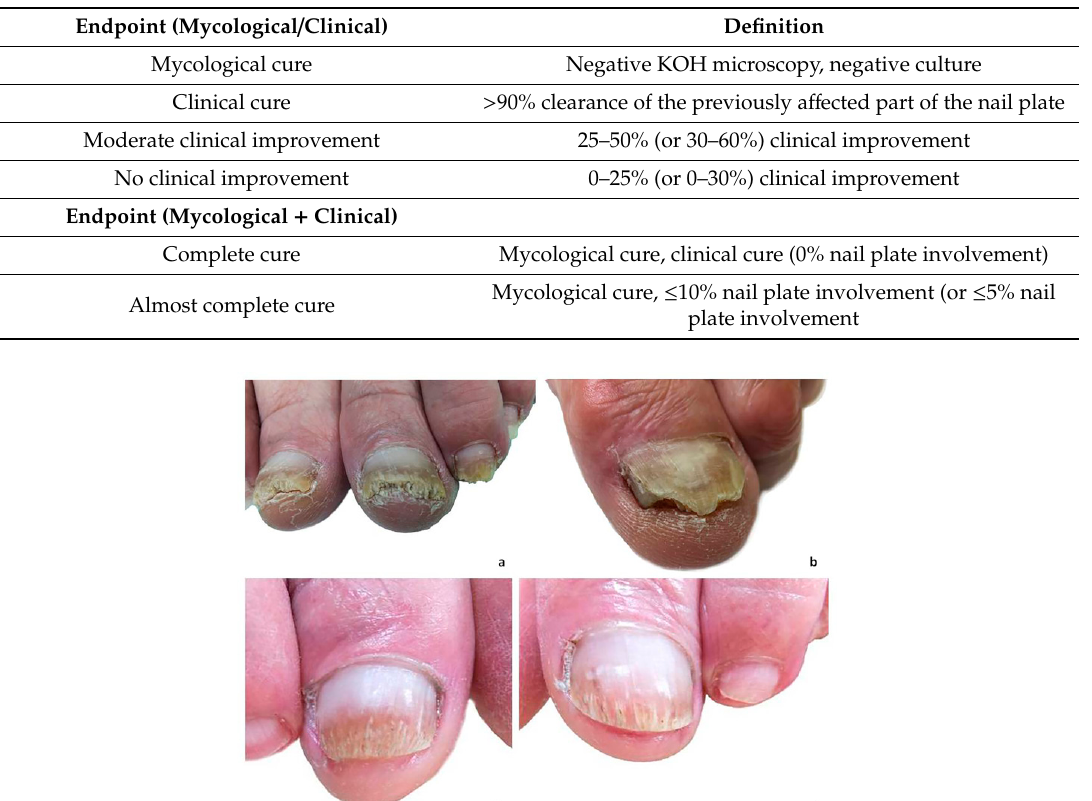
Table 2. E ffi cacy measures for topical and oral treatment of onychomycosis. Clinical and mycological endpoint evaluation criteria were taken from a study by Gupta and Studholme [53] and modified for the purposes of this study.